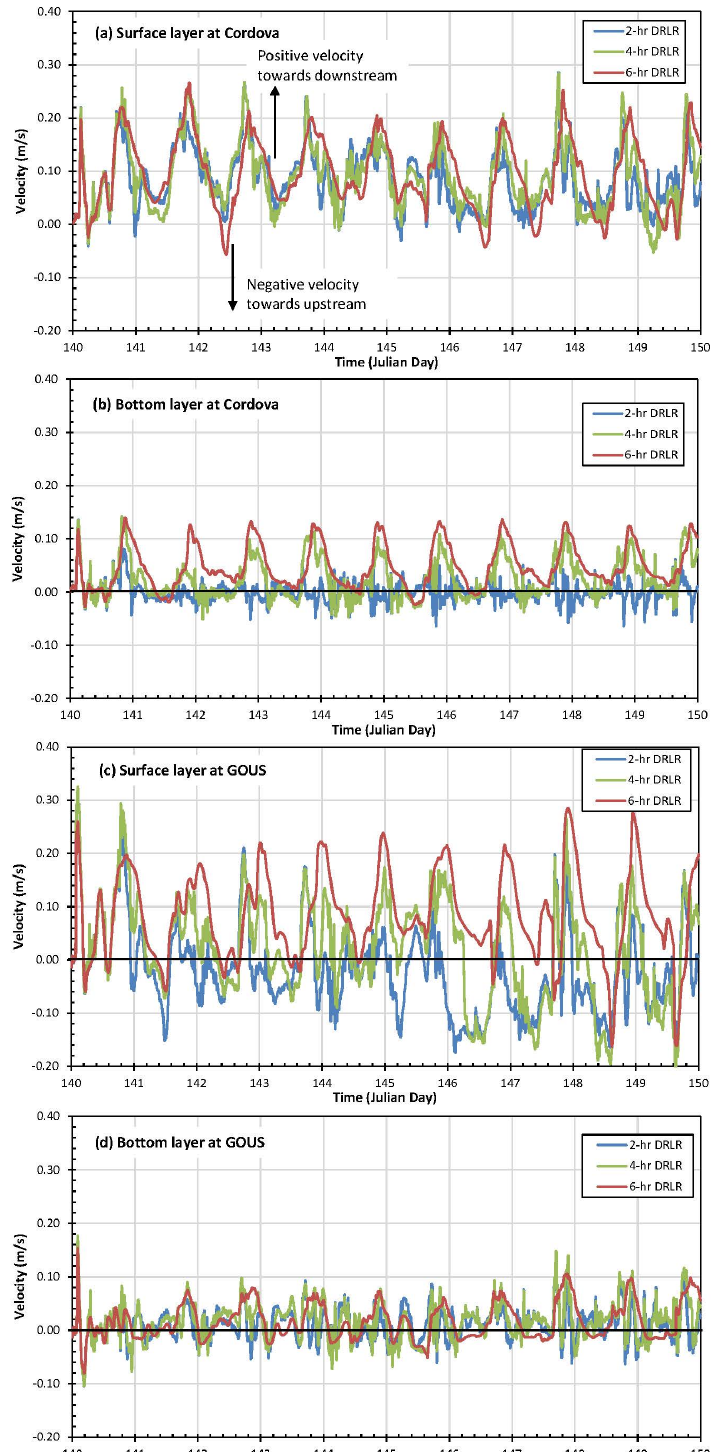
Figure 4. Time series of simulated velocities in the surface and bottom layers at the centerlines of Cordova and GOUS when DRLRs at SDT last 2, 4 and 6 h each day. ( a ): Surface layer at Cordova; ( b ): Bottom layer at Cordova; ( c ): Surface layer at GOUS; ( d ): Bottom layer at